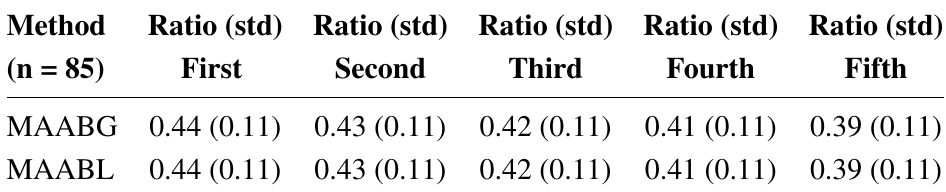
Table 2. Ratio averages of diastolic blood pressure (DBP) measurements by the maximum amplitude algorithm using Bayesian with Gaussian (MAABG) and the maximum amplitude algorithm using Bayesian with Laplacian (MAABL); n = 85 is number of subject; std is standard